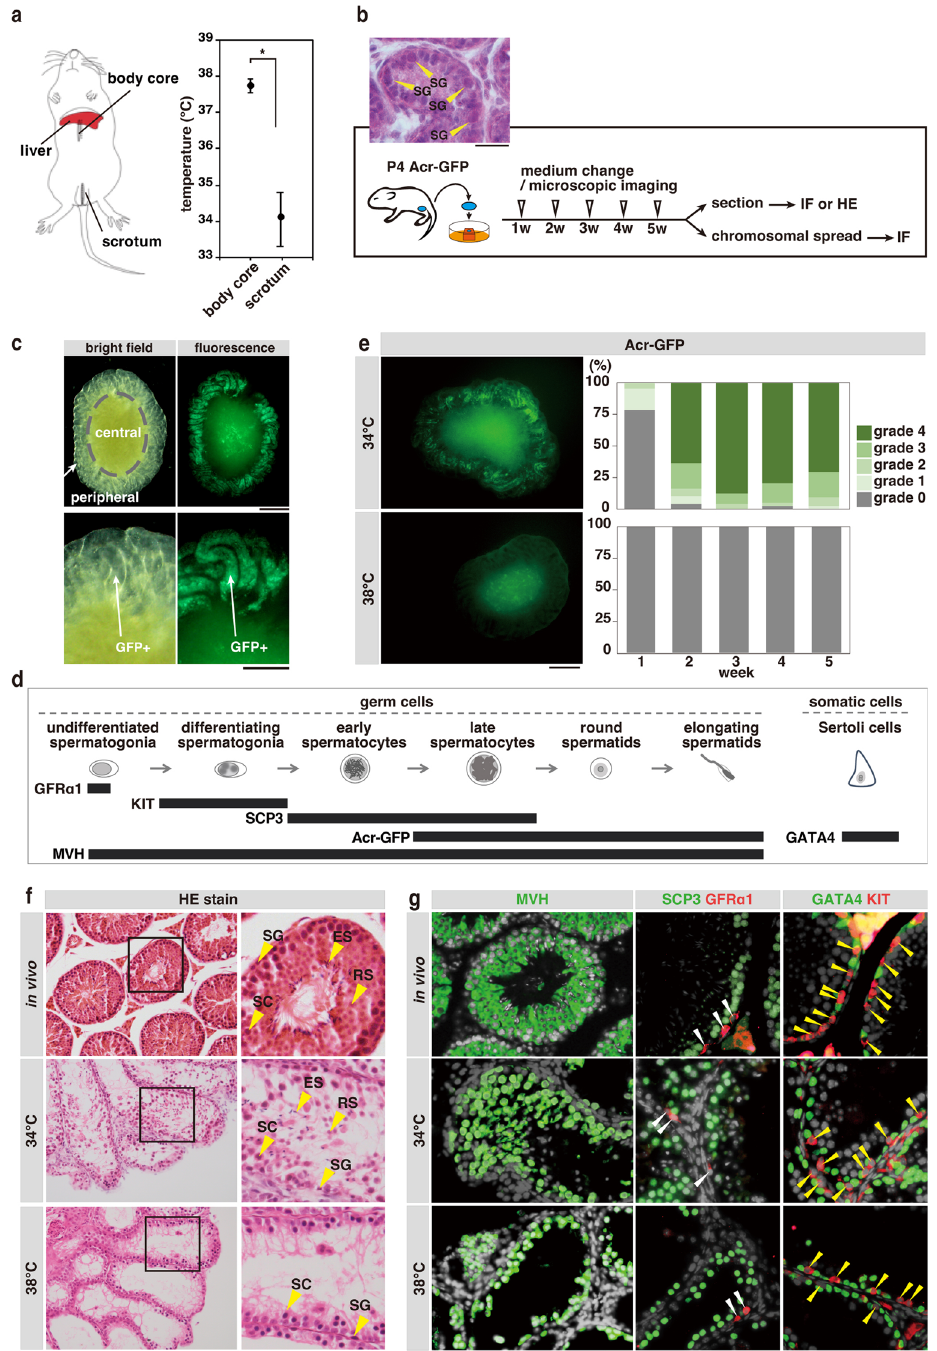
Fig. 1 Ex vivo testis explant culture and heat sensitivity of mouse spermatogenesis. a Scrotal and abdominal temperatures in mice measured using an implanted thermometer, shown as a schematic diagram in the left panel. Mean±SD of body core and testis temperatures measured in 14 individuals and averaged over the times of a day are shown in the right panel (see Supplementary Fig. 1a). * p <0.01. b Outline of the ex vivo culture experiments and a representative image of a P4 Acr - GFP mouse testis. Scale bar, 20 μ m; SG spermatogonia, IF immuno fl uorescence, HE hematoxylin-eosin staining. c Representative fl uorescence microscopic images of a testis explant harboring Acr-GFP transgene after fi ve weeks of culture as shown in b . Bright fi led (left) and fl uorescence (right) images are shown. Scale bars; 500 and 250 μ m in upper and lower panels, respectively. GFP + seminiferous tubules were observed in the periphery while the central part was necrotic. d Schematic representation of mouse spermatogenesis and the expression of marker proteins used in this study. Early spermatocytes (Acr-GFP − ) include leptotene, zygotene, and pachytene before stage IV, while the late spermatocytes (Acr-GFP + ) include pachytene after stage IV and diplotene. e Acr-GFP fl uorescence images of testis explants after fi ve weeks of culture at 34°C and 38°C (left), and the summary of their GFP grade (0 – 4) over fi ve weeks of culture at 34°C ( N = 99) and 38 °C ( N = 51) (right). See also Supplementary Fig. 1c-d. Scale bar, 500 μ m. f , g Representative images of sections of Acr-GFP mouse (5 week old) testes (in vivo) and the testis explants cultured for fi ve weeks at 34°C and 38°C, stained with hematoxylin-eosin ( f ) and for indicated marker proteins ( g ). In ( f ), enlarged images are shown on the right. In ( g ), white and yellow arrowheads indicate GFR α 1 + and KIT + spermatogonia, respectively. SG spermatogonia, SC spermatocytes, RS round spermatids, ES elongating spermatids. Scale bars: 100 and 40 μ m in ( f , g ), respectively. COMMUNICATIONS BIOLOGY| (2022) 5:504 |https://doi.org/10.1038/s42003-022-03449-y|www.nature.com/commsbio